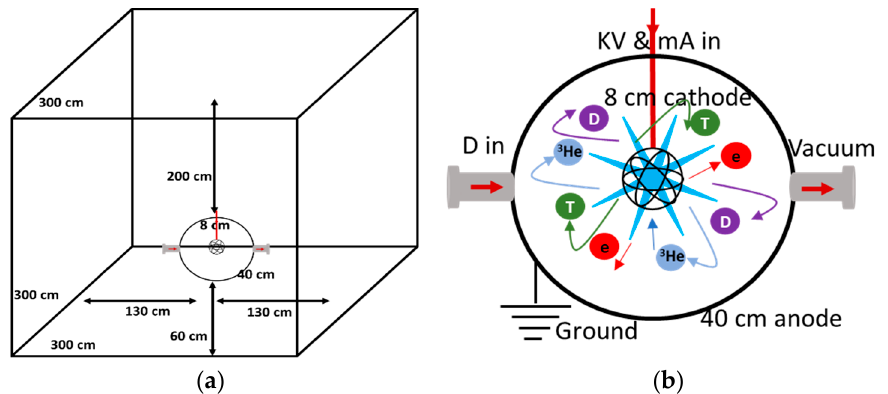
Figure 1. The 3 × 3 × 3 m 3 lab layout, including the radiation source at the centre ( a ), the IECF chamber con fi guration system layout, and the ion traces ( b ).